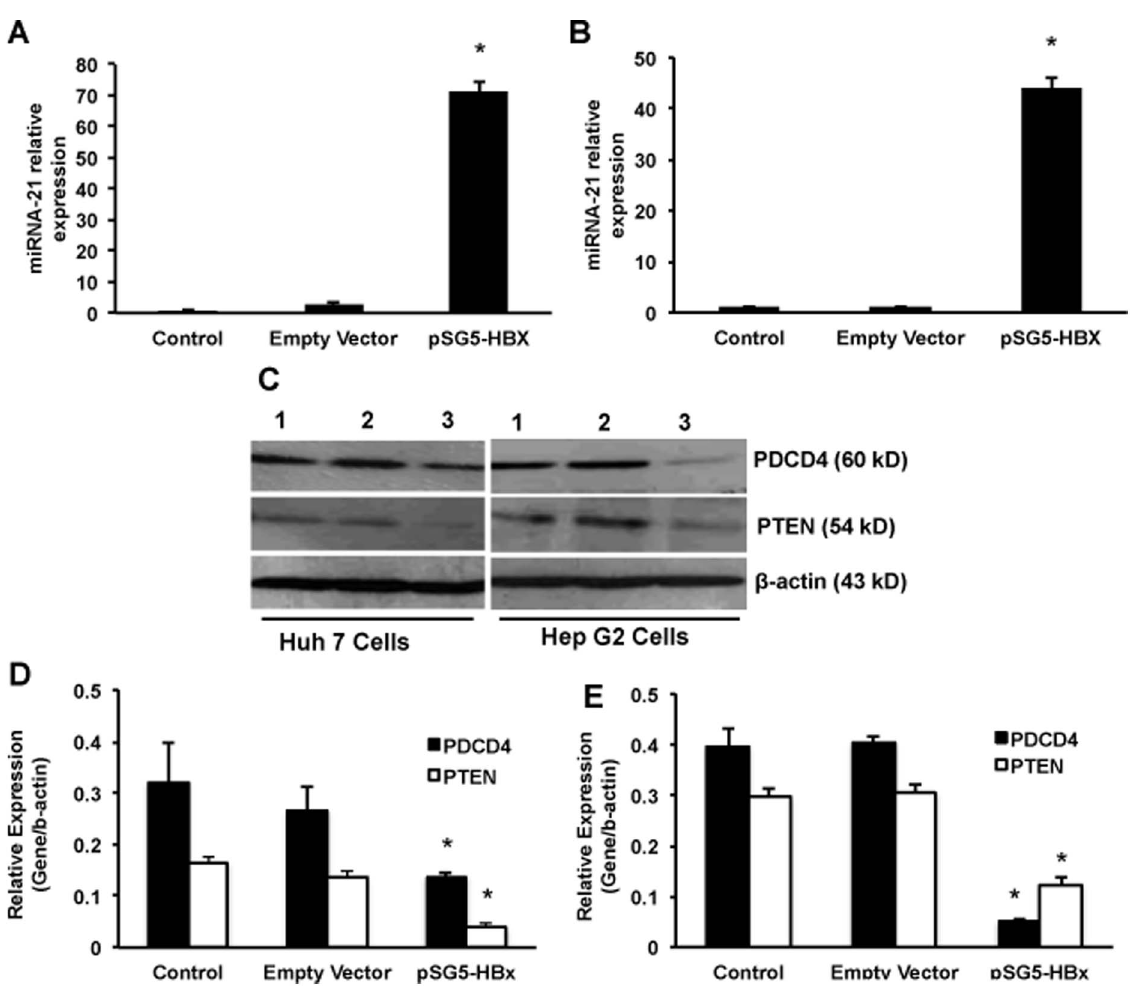
Figure 3. Effect of HBx on PDCD4 and PTEN. HBx protein was over-expressed in both Huh 7 (A) and Hep G2 (B) cells and the expression of miRNA-21 was estimated using real time PCR (n=3; *p , 0.001). HBx was over-expressed in both Huh 7 and Hep G2 cells and the target proteins for miRNA-21 were determined using Western blots. This picture is a representative of the three experiments (C). Lane 1, Control; lane 2, Empty vector; and lane 3, HBx transfected cells. b -actin was used as loading control. These Western blots were quantified using Li-COR’s image studio lite software and the data are presented for Huh 7 (D) and Hep G2 (E) cells (n=3; *p , 0.05).